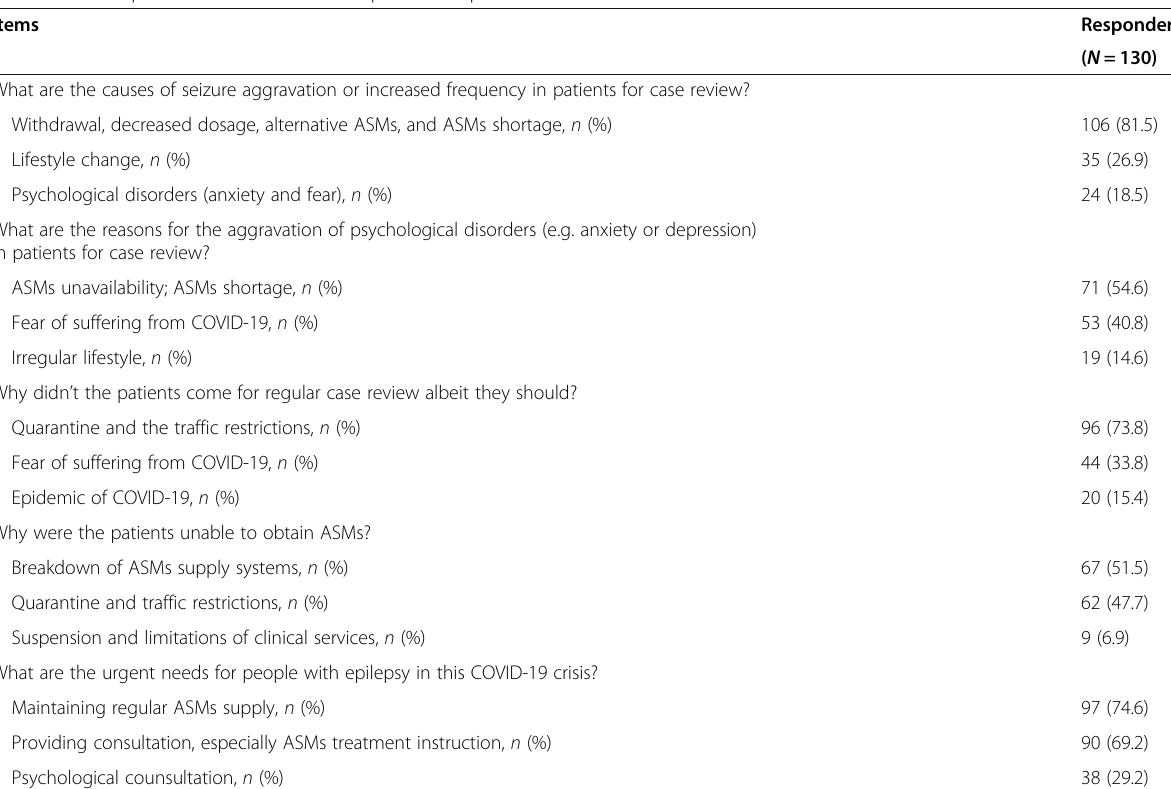
Table 2 The top three answers for each qualitative question